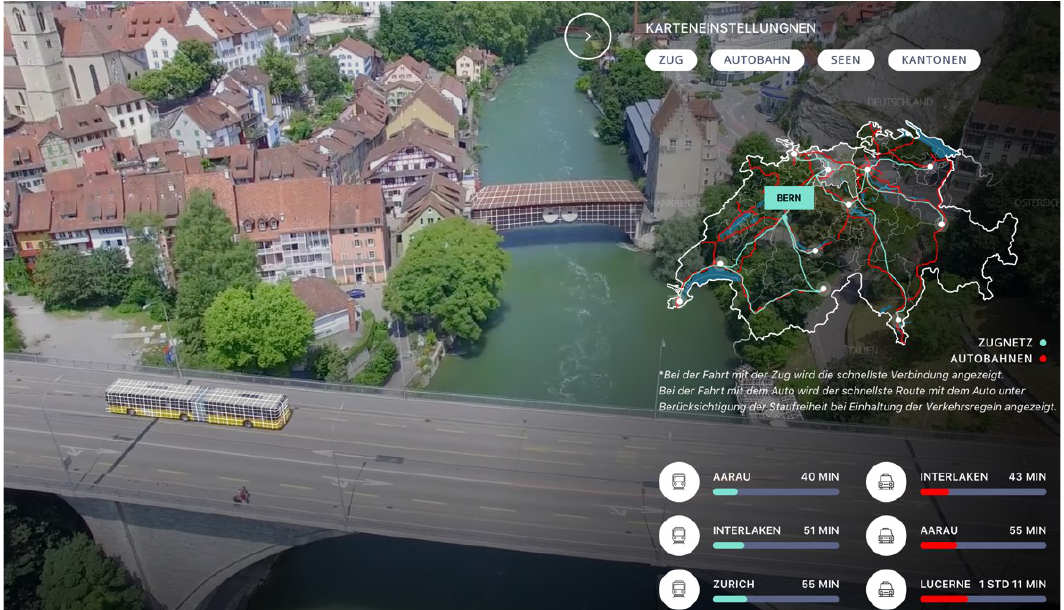
Figure 3a. Data visualizations about the connectedness of the canton of Aargau in a slide in container.